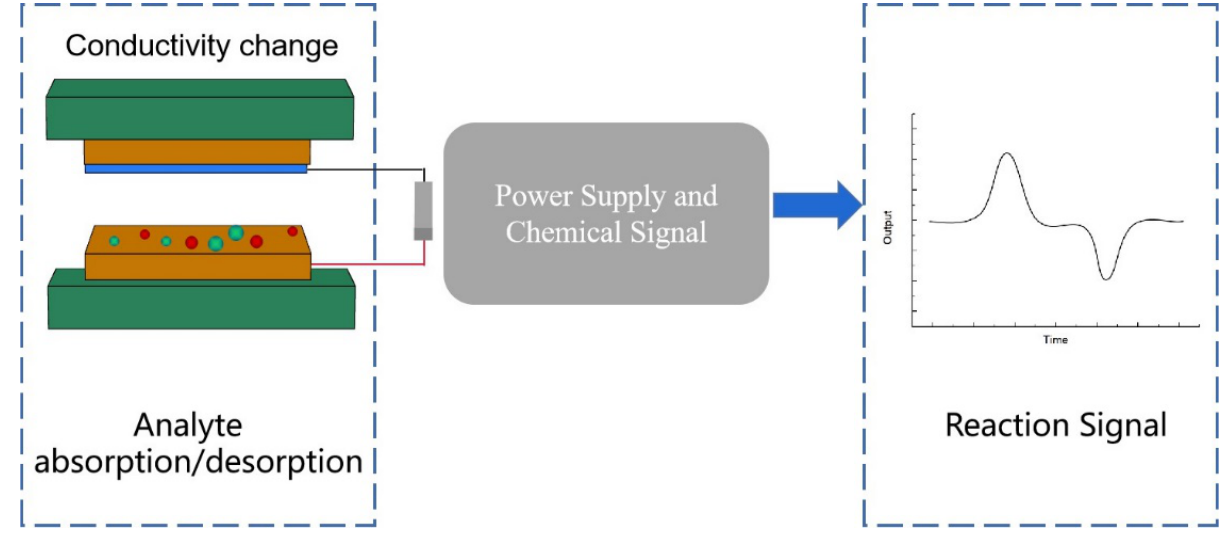
Figure 10. Schematic illustration of TENG-based active CSSs.